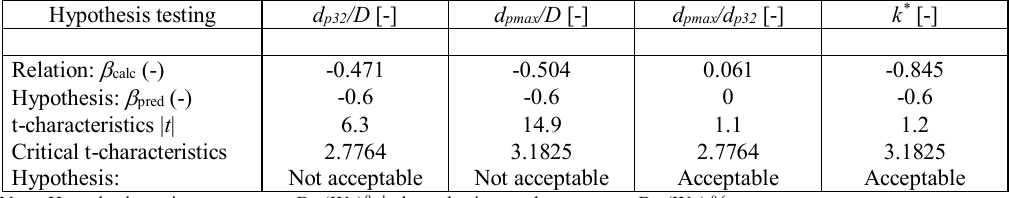
Table 10. Dimensionless correlations – hypothesis testing; Rushton turbine